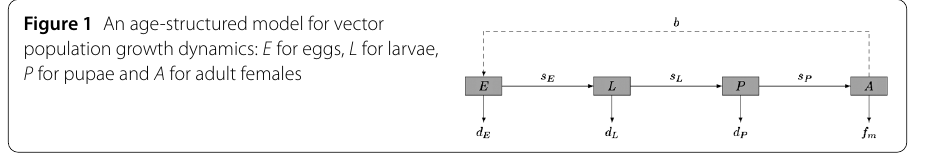
Figure 1 An age-structured model for vector population growth dynamics: E for eggs, L for larvae, P for pupae and A for adult